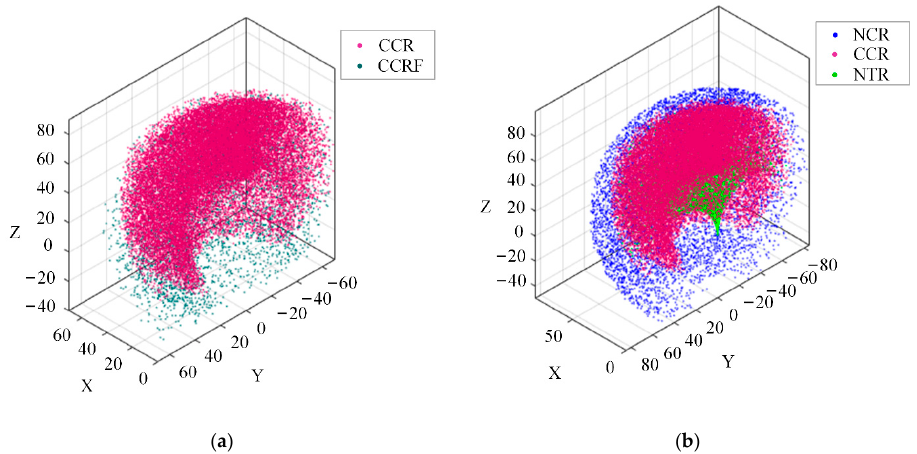
Figure 10. Workspace comparison of continuum robots. ( a ) The workspace considering the stability problem and the workspace without considering the stability problem, ( b ) The workspaces of different continuum robots.